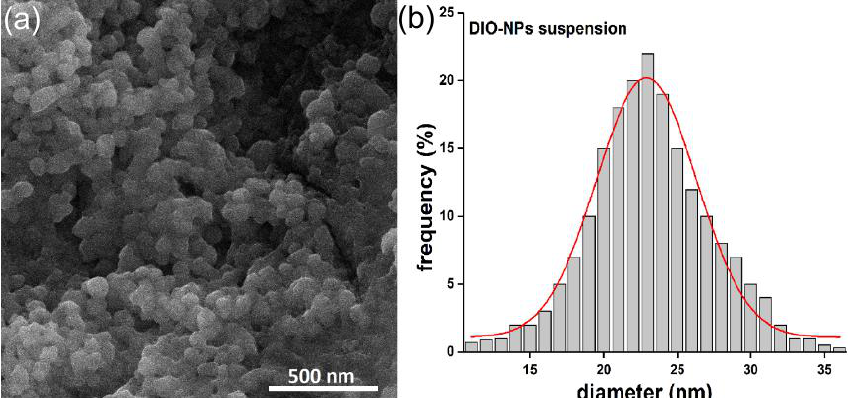
Figure 3. SEM image of DIO-NPs suspension ( a ) and particle size distribution ( b ).